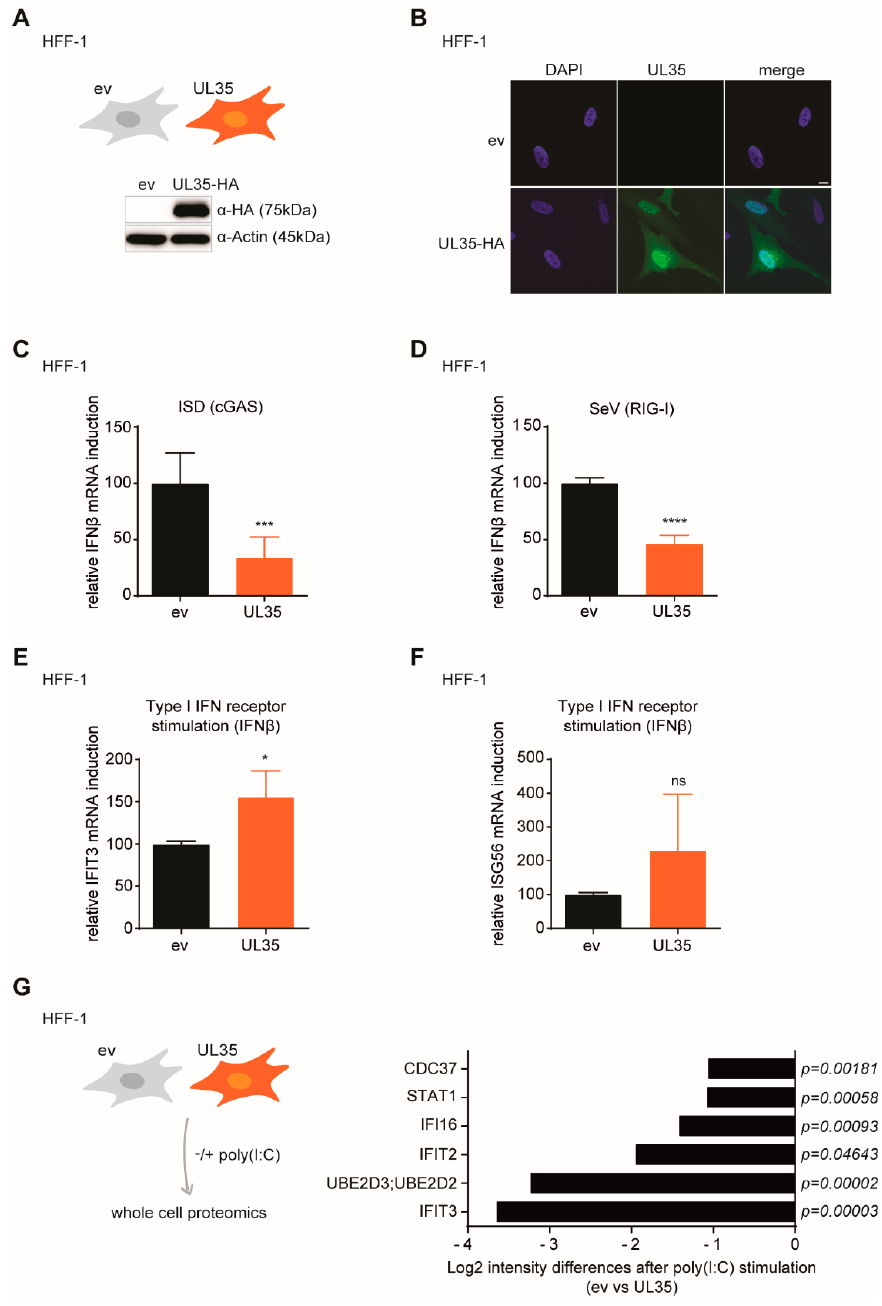
Figure 5. UL35 negatively modulates the IFN β response in primary human fibroblasts. ( A ) Expression of HA-tagged UL35 was verified by immunoblotting of lysates from HFF-1 stably expressing UL35- HA or empty vector control. Actin served as loading control. ( B ) HFF-1 UL35-HA cells were analyzed by immunofluorescence with an HA-specific antibody (green) together with DAPI staining for nuclei